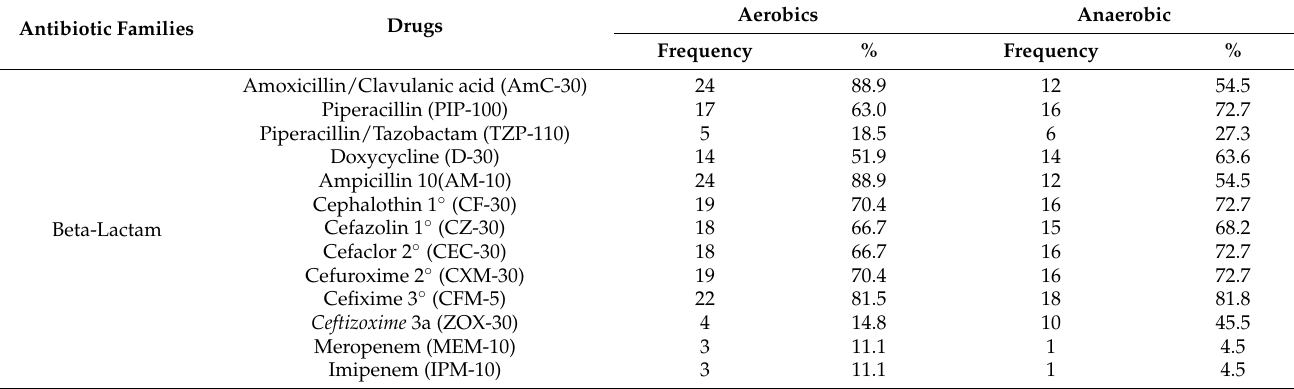
Table 3. Whole antibiograms characteristics of beta-lactam resistant bacteria isolated from feces cultures of humans in healthy